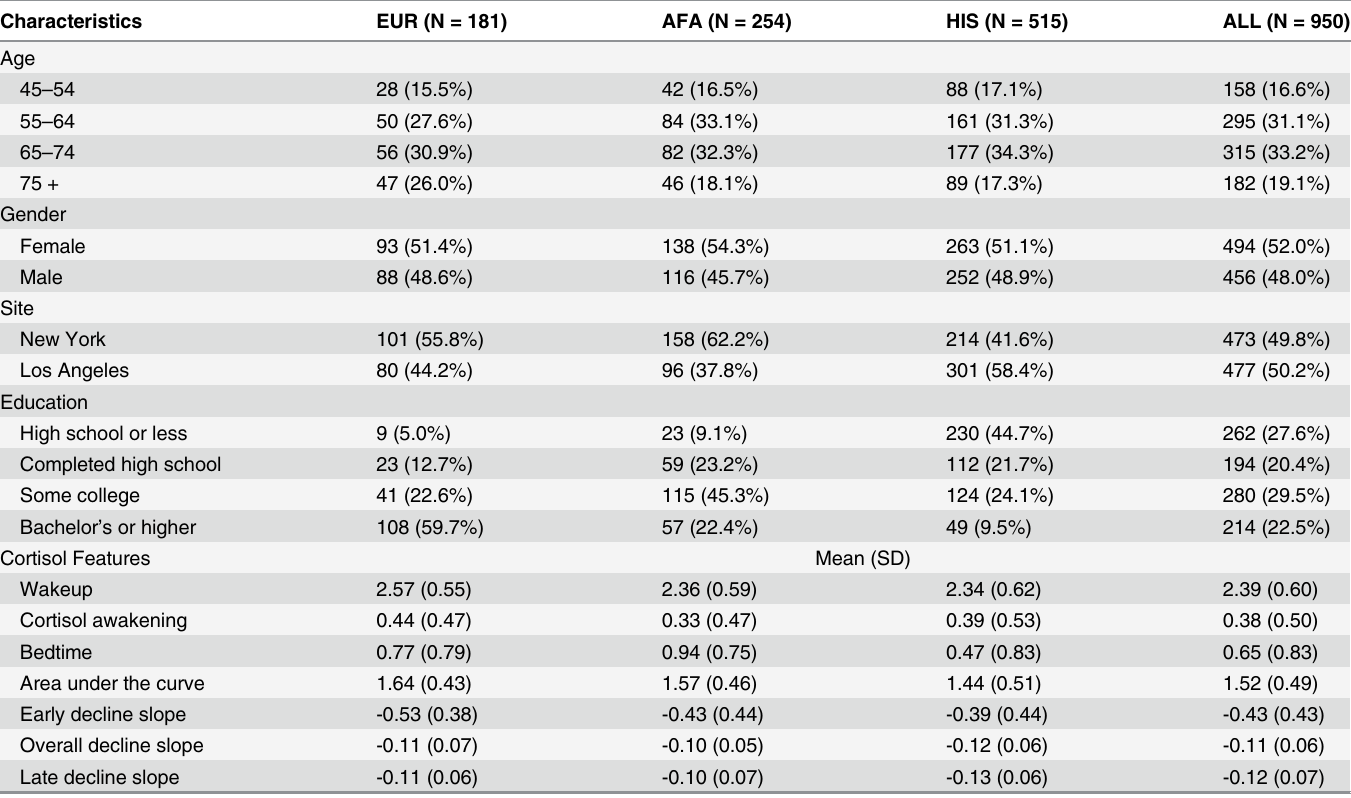
Table 1. Characteristics of MESA Stress Study